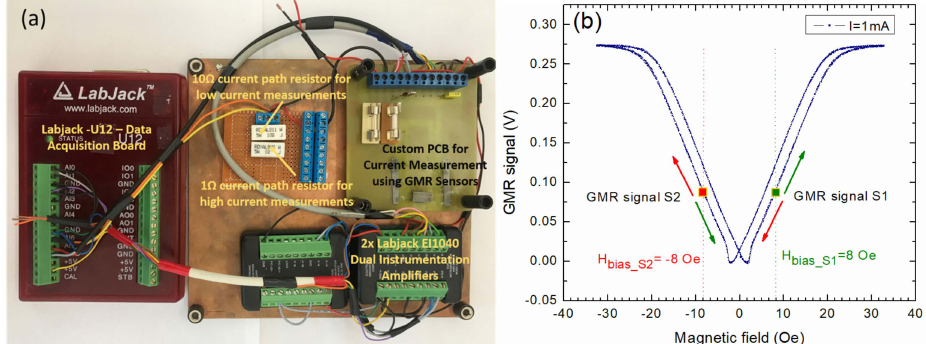
Figure 12. Di ff erential measurement system: ( a ) experimental setup; ( b ) mode of operation illustration for H bias = 8 Oe: when a current I is applied through the U-shaped band, the voltage on sensor 1 increases (green arrow) whereas the voltage on sensor 2 decreases (orange arrow). For H bias = − 8 Oe, the voltage on sensor 1 decreases whereas the voltage on sensor 2 increases when the same current I is applied (see Figures 8 and